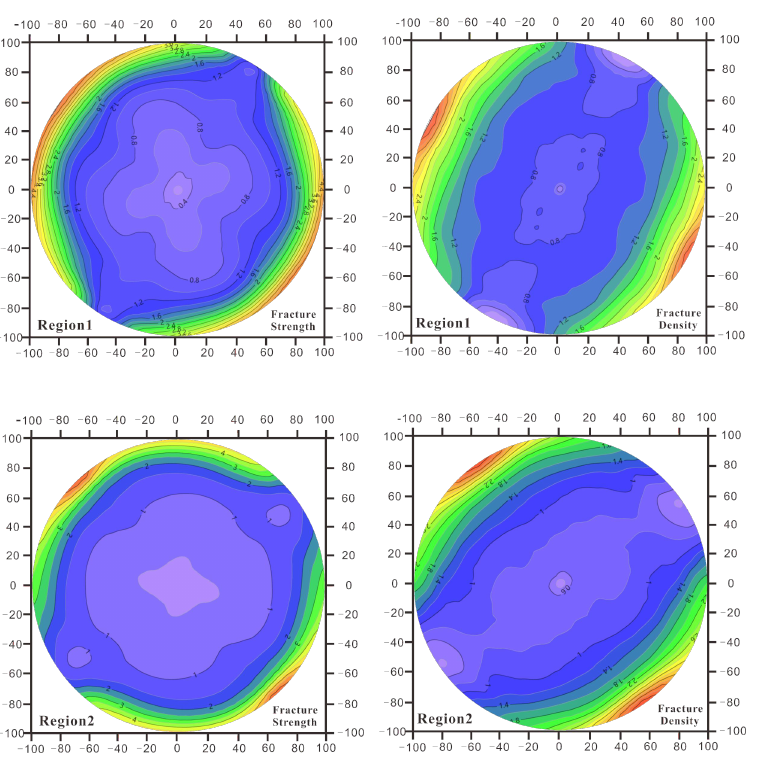
Figure 19. Semi-variance contour map of fracture strength and fracture density of lineaments in study area 1 and study area 2 extracted by the traditional Canny algorithm.